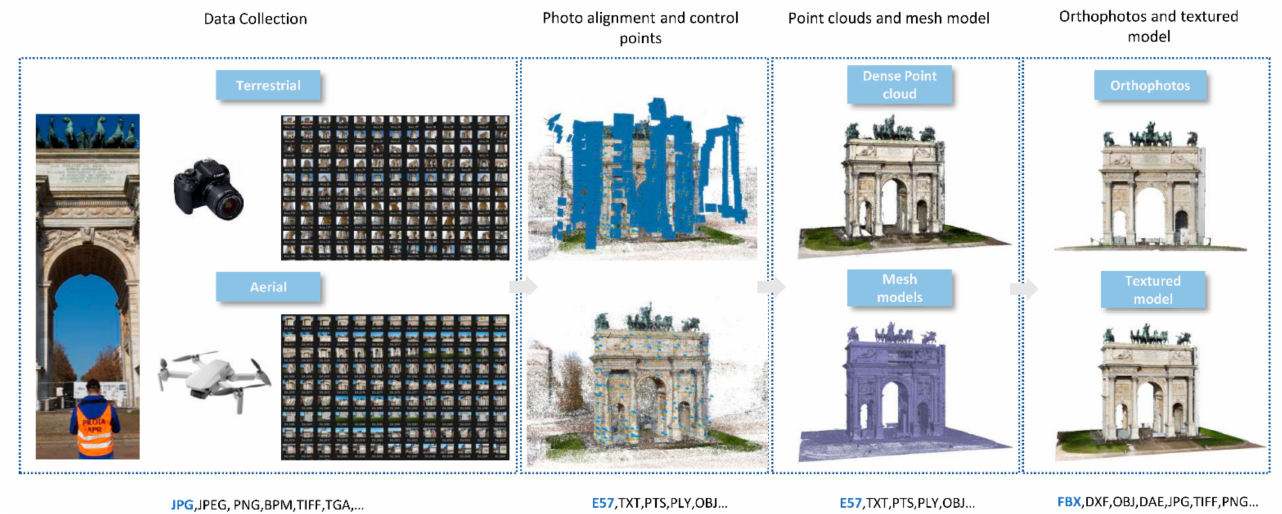
Figure 6. Orthorectification process and mesh textured model generation with terrestrial and UAV images acquired over the Arco della Pace: pictures, textured model and related exchange